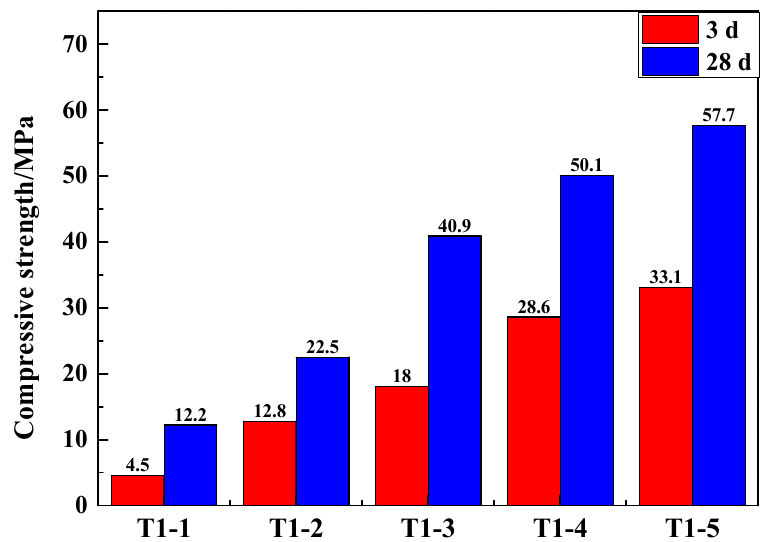
Figure 1. Compressive strength of samples of different SSCND–cement ratios after 3 and 28 days of